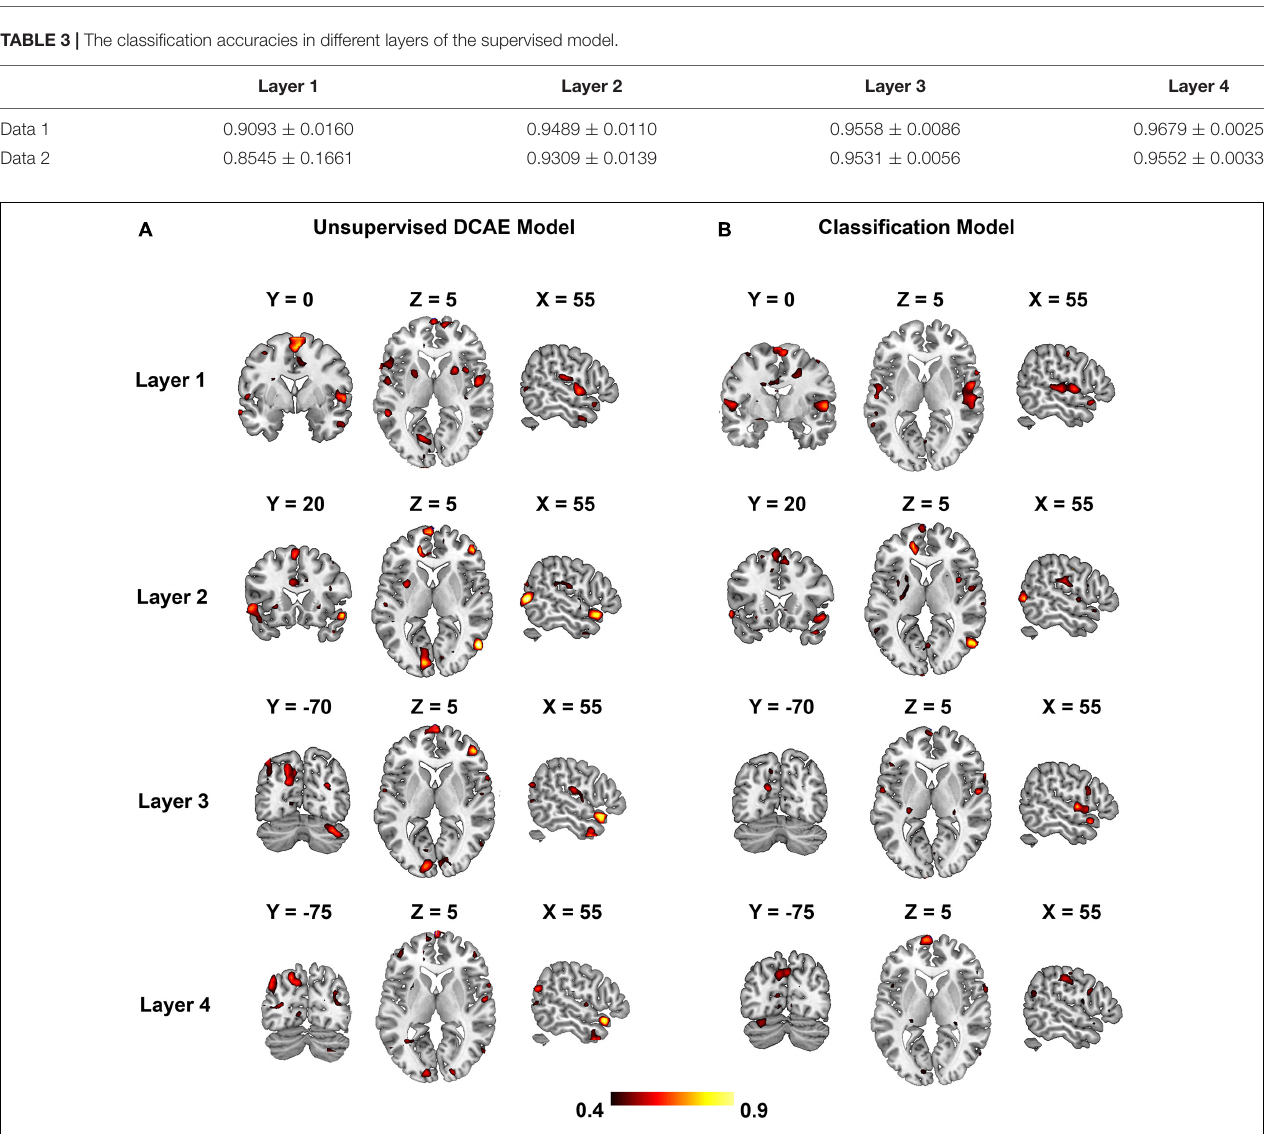
FIGURE 6 | The encoding performance for each layer in the unsupervised DCAE model (A) and supervised classification model (B) .